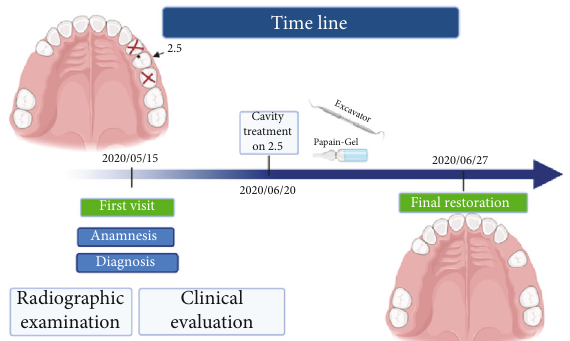
Figure 1: Timeline according to the CARE protocol.